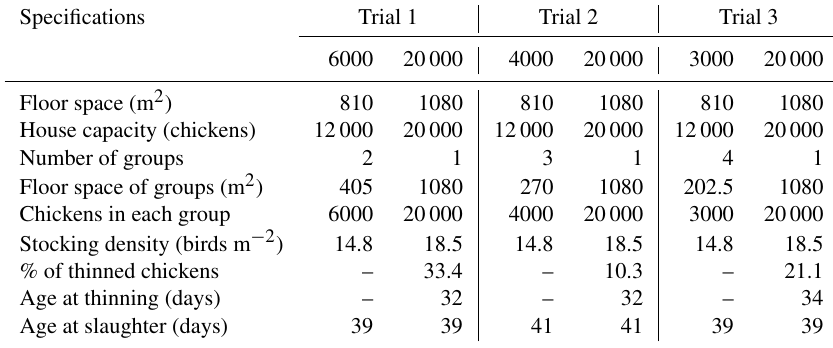
Table 1. Specifications of houses and trial designs ∗ .